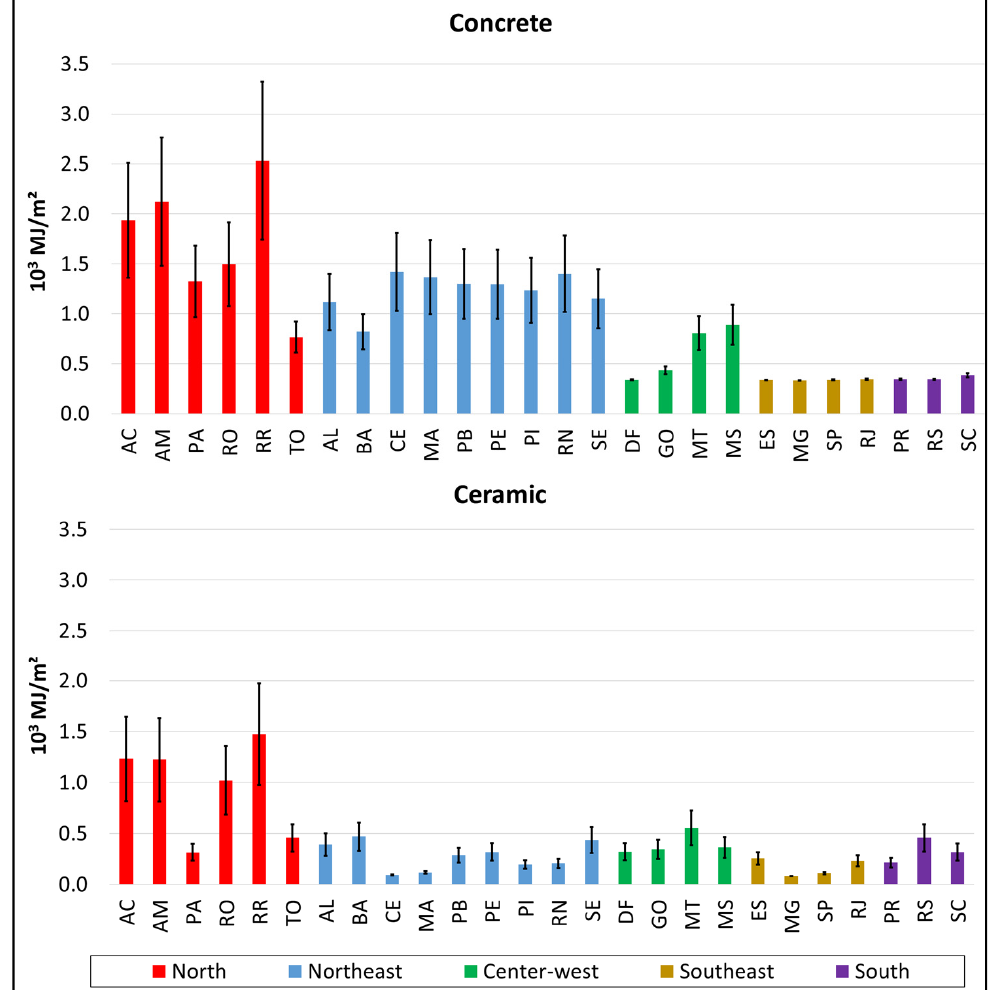
Figure 6. Total Resource Depletion impact. The error bars represent the standard deviation due to transportation scenarios.